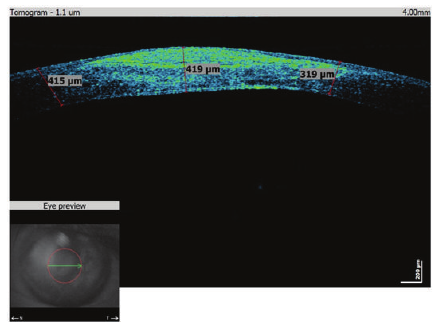
Figure 4: Preoperative SOCT anterior of the left